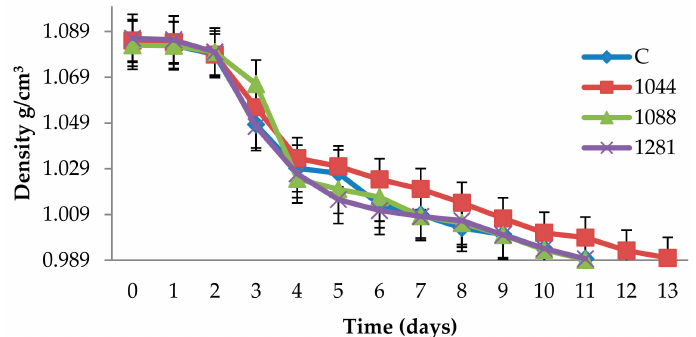
Figure 2. Daily fermentation monitoring in Narince must be fermented with di ff erent yeasts. C represents wine inoculated with control strain, 1044 is wine inoculated with 1044, 1088 is wine inoculated with 1088, and 1281 is: wine inoculated with